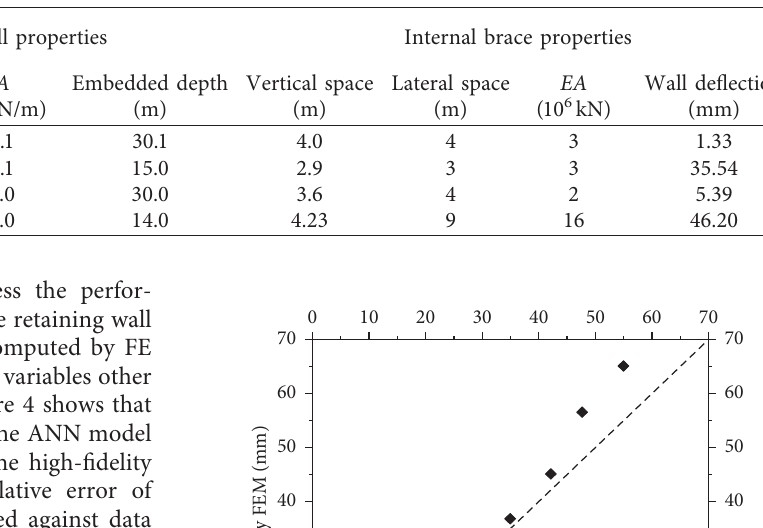
Table 2: Examples of synthetic samples employed to train the ANN model.